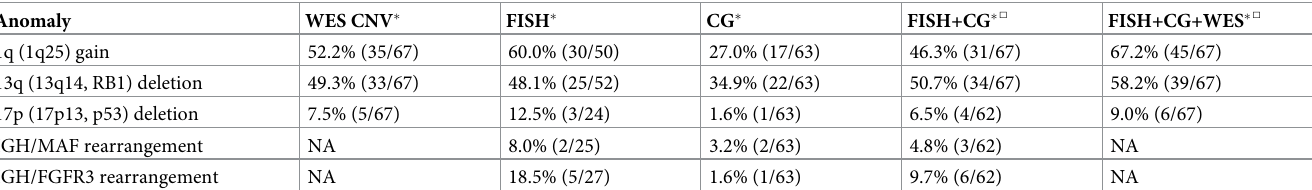
� In parentheses, Number of patients with positive results/Number of patients with total MM cases tested. □ Patients with positive on at least one of the tests were